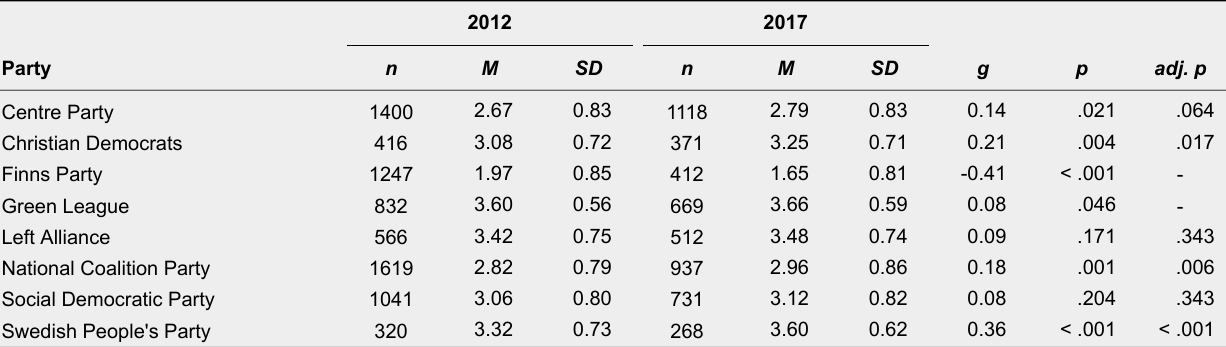
Party-Specific Descriptive Statistics and Standardized Mean Differences in Acceptance of Refugees Between Newcomers of 2012 and 2017